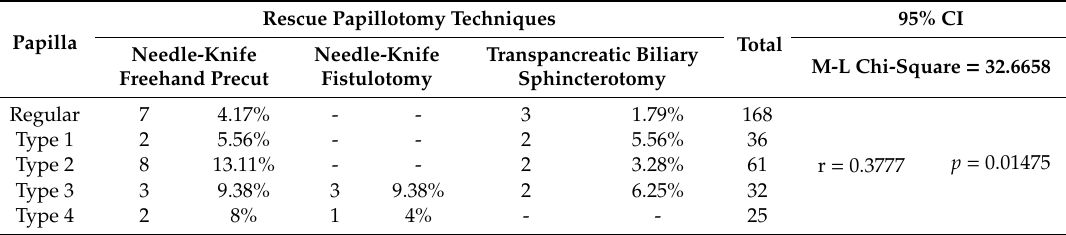
95% CI Total M-L Chi-Square = 32.6658